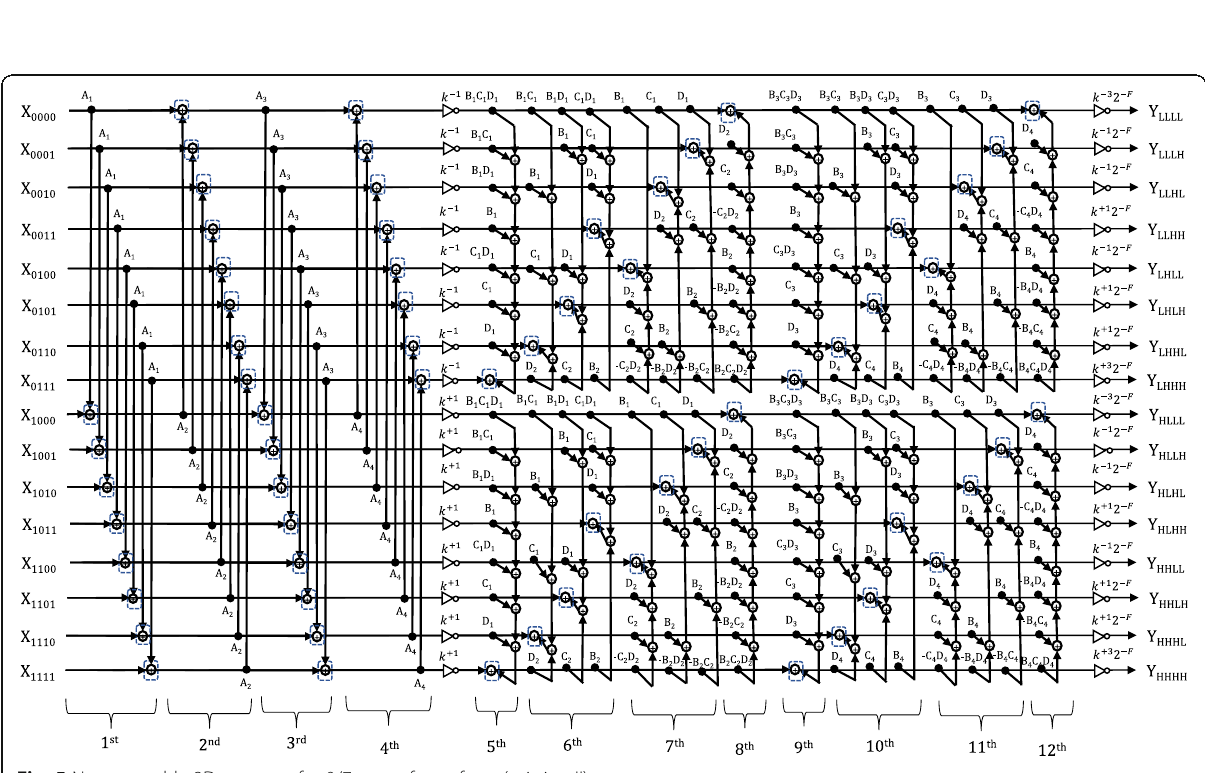
Fig. 5 Non-separable 3D structure for 9/7-type of transform (existing